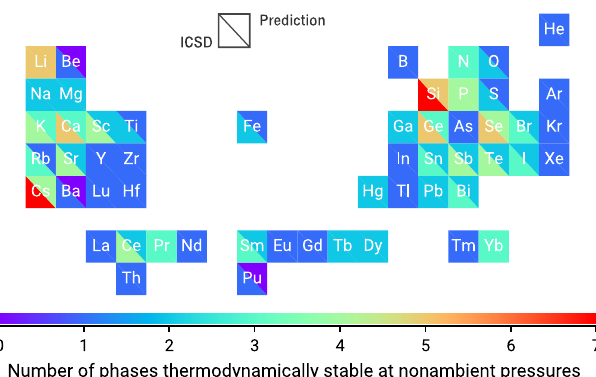
FIG. 5. Comparison of predictions of high-pressure elemental phases from the LAE model against experiment. For each element, the number of (a) unique phases reported experimentally and (b) those predicted by the linear enthalpy model to be thermodynamically stable at nonambient pressures are indicated by the color of the bottom-left and top-right halves, respectively, of the corresponding tile in the periodic table. Overall, the model correctly predicts about 75% of the high-pressure phases in the ICSD to be thermodynamically stable at nonambient pressures.